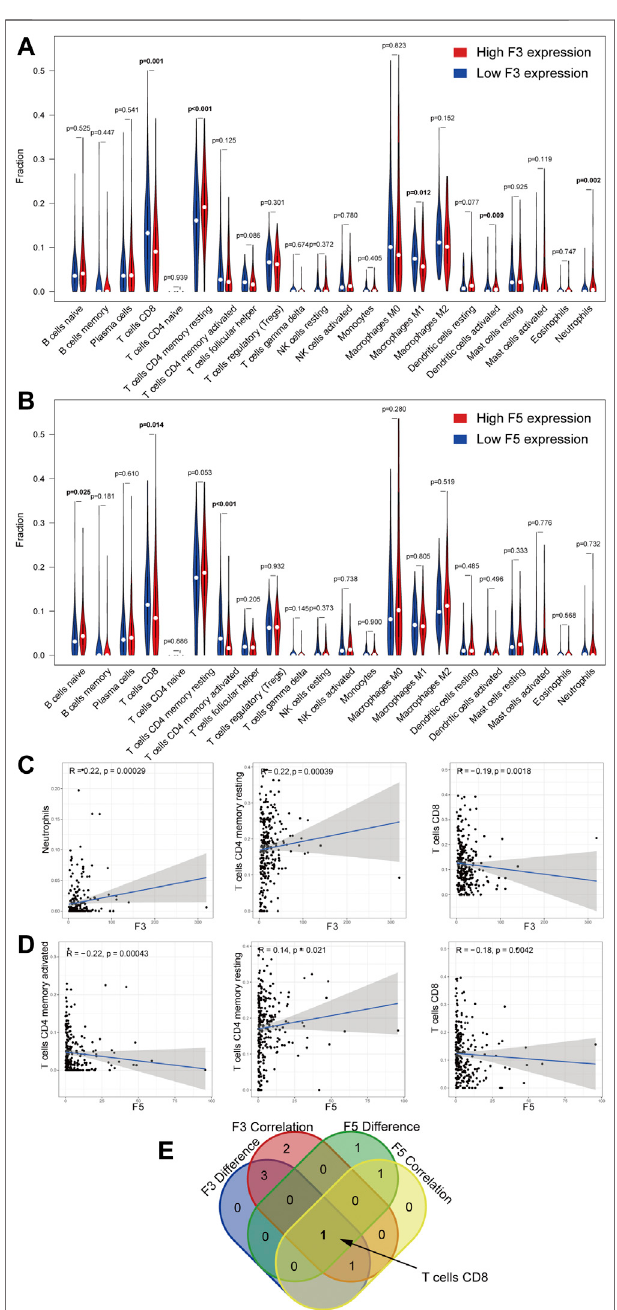
FIGURE 9 | Correlation of the TIC proportion with the expression of D-dimer-related genes. (A – B) Violin plot displaying the ratio differentiation of 22 immune cell types between STAD tumor samples with low or high F3 and F5 expression relative to the median gene expression level. Wilcoxon rank sum for the signi fi cance test. (C – D) Scatter plots showing the correlation of the top 3 TIC proportions with F3 and F5 expression ( p < 0.05). Pearson ’ s coef fi cient for the correlation test. (E) Venn plot displaying the overlapping F3 and F5 cells — namely, CD8 T